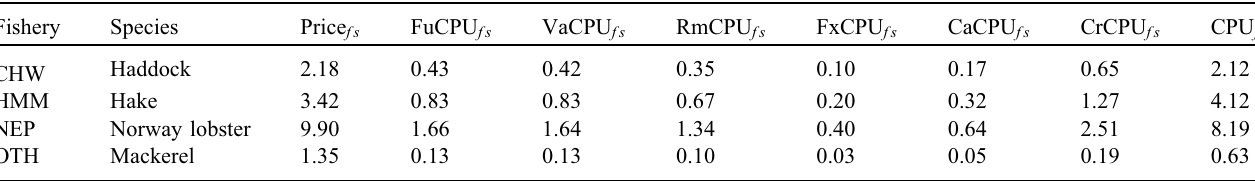
Table A.9. Cost structure for 4 selected species of interest landed by the polyvalent general fl eet segment þ 18m in 2019.